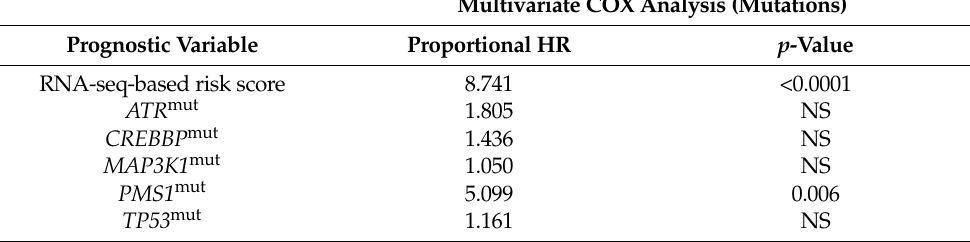
Table 3. Cox univariate HR: hazard